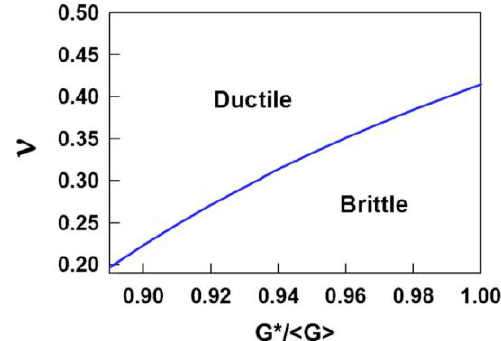
Figure 8. Plasticity or brittleness of BMGs depends on Poisson’s ratio as well as local fluctuations in shear modulus. G* is the local shear modulus and <G> is the global shear modulus of a glassy alloy. Reproduced from [85] with permission from Applied Physics Letters. Copyright (2008), AIP Publishing LLC (Melville, NY,